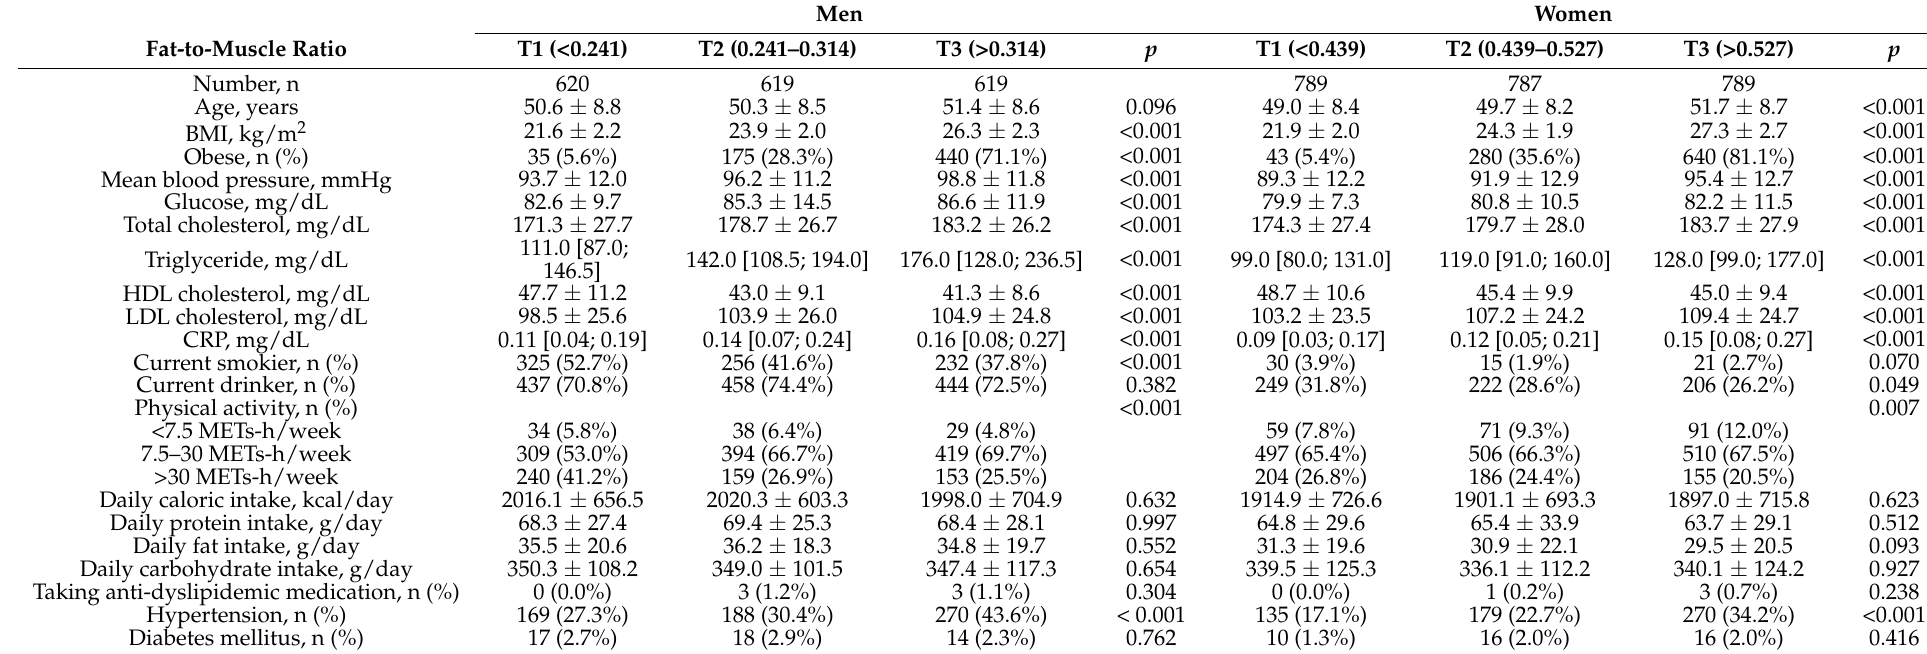
Table 1. Baseline characteristics of the study